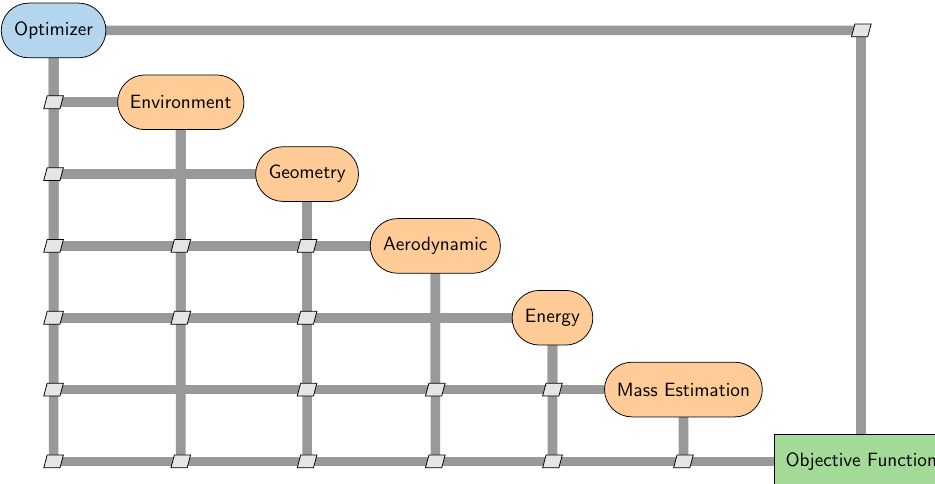
Figure 6. Framework for multidisciplinary design, analysis, and optimization